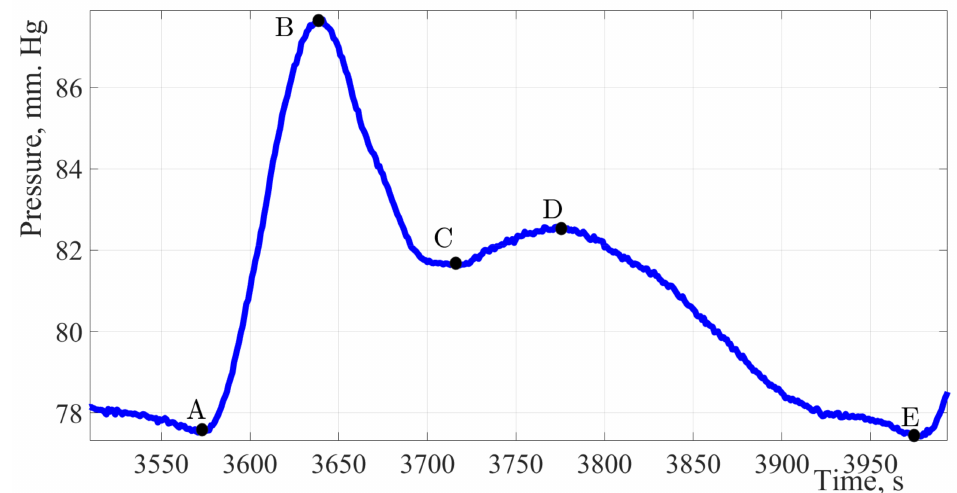
Figure 6. The pulse wave signal of a woman 30 years of age.